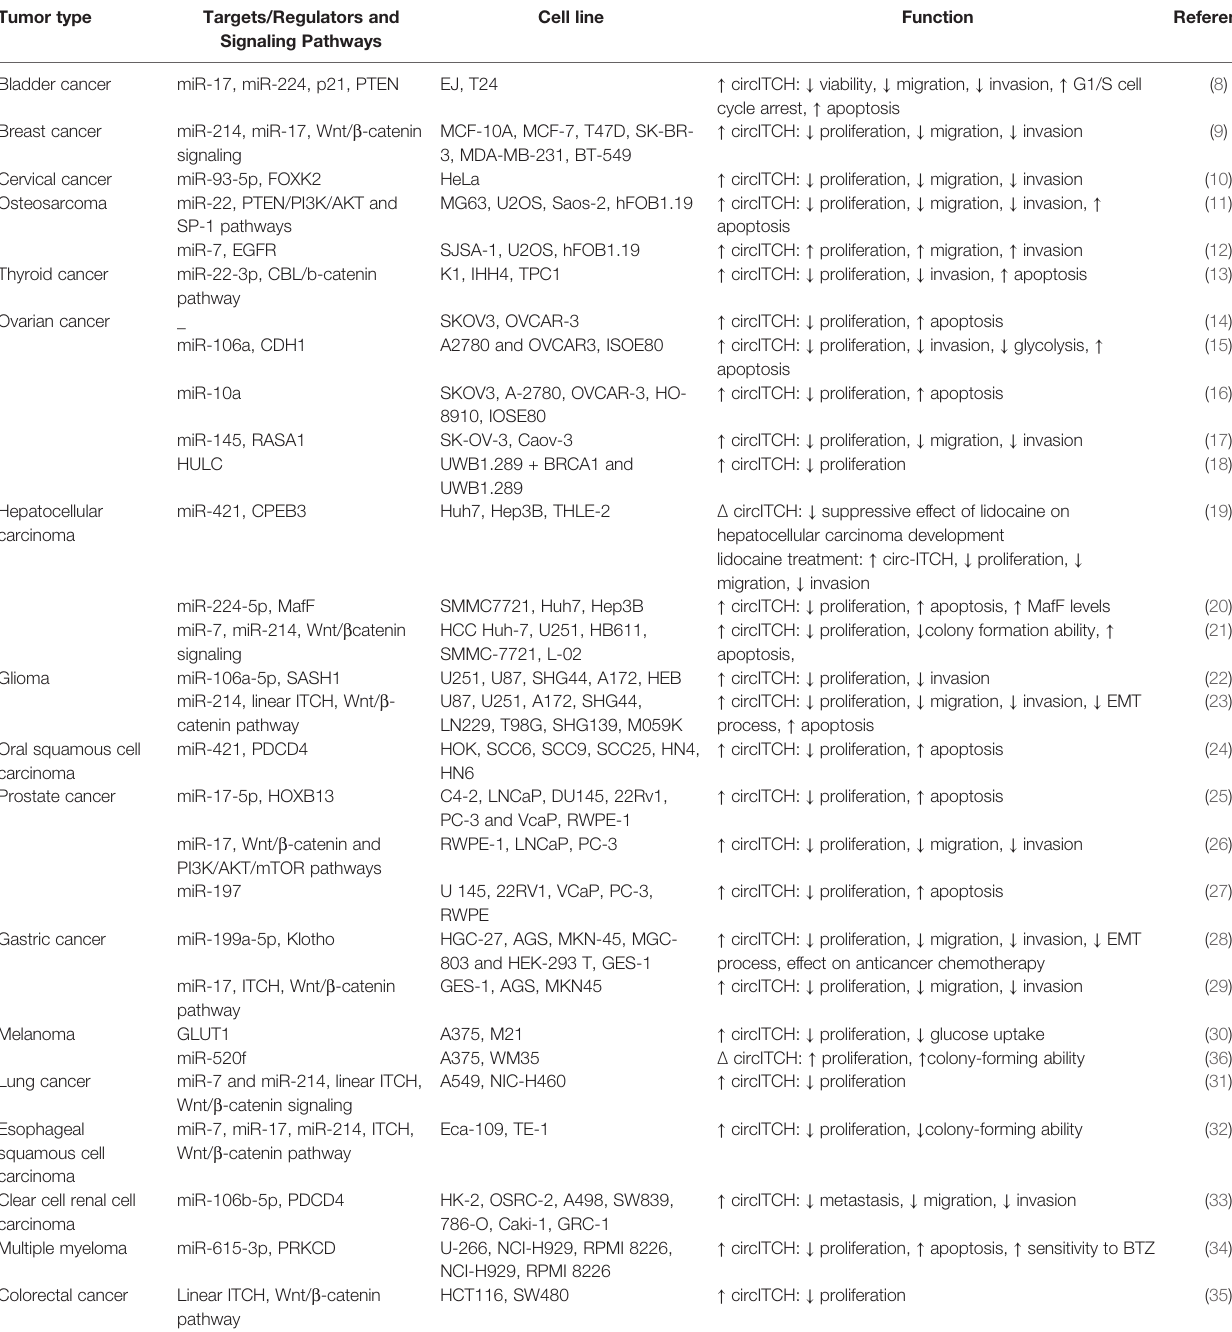
TABLE 1 | Expression and function of circITCH in cancer cell lines ( Δ : knock-down or deletion, BTZ: